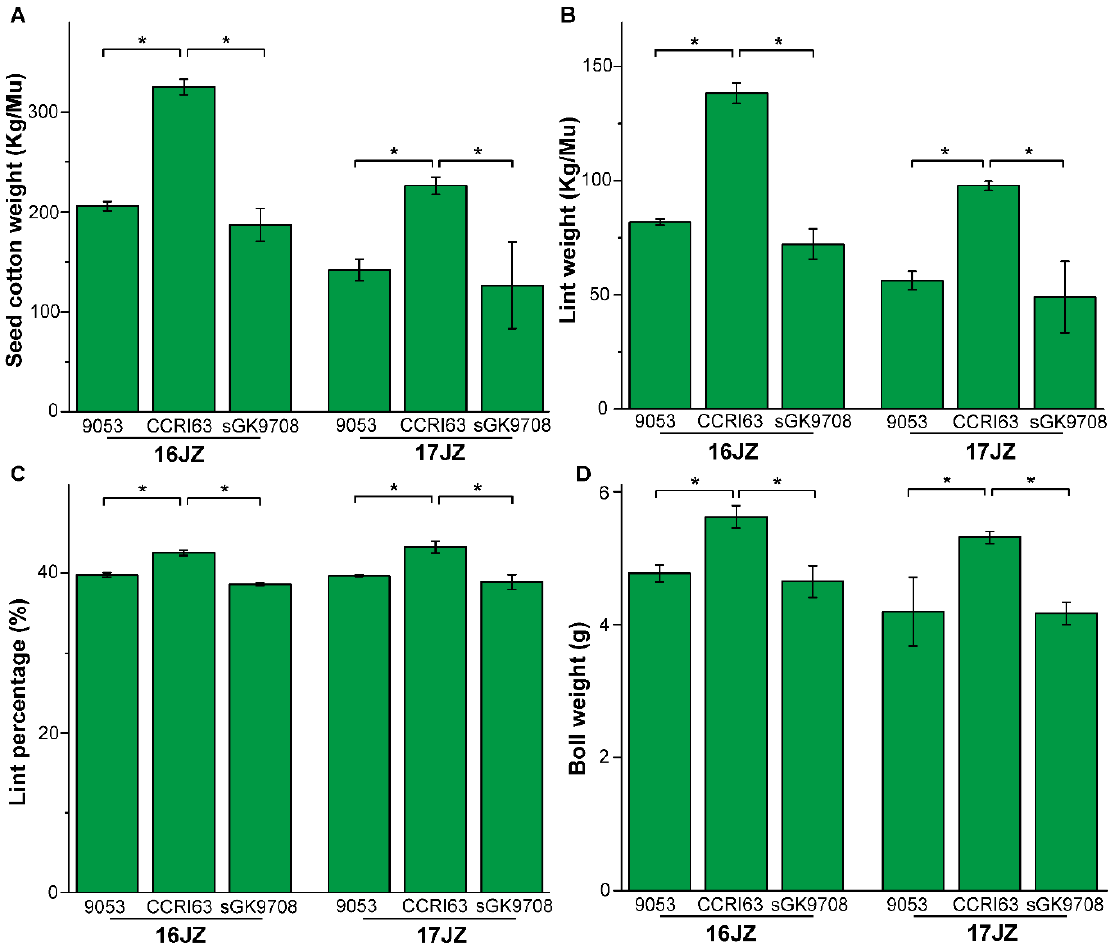
Figure 1. Traits performance of three accessions. ( A ) Seed cotton weight. ( B ) Lint weight. ( C ) Lint percentage. ( D ) Boll weight. Data are represented as average values. The asterisk symbol (*) indicated reaching a significant level at 5%.